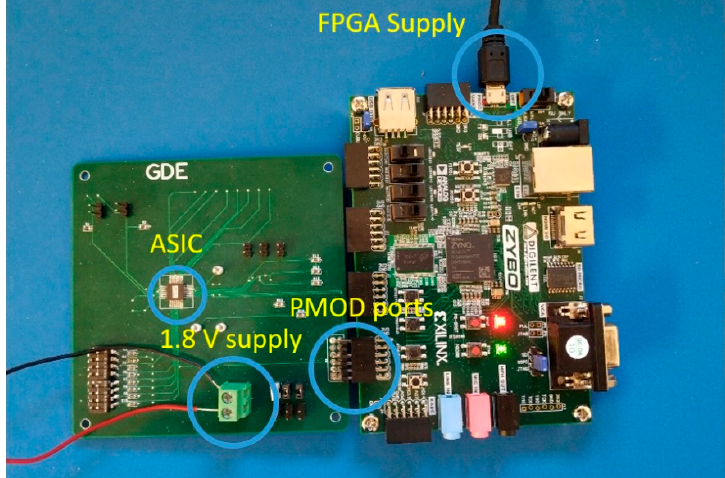
Figure 4. PCB (Printed Circuit Board) for the ASIC test setup connected to the Zybo board used to feed the clock and the reset signals. PMOD (Peripheral Module) ports have been used for the connection.